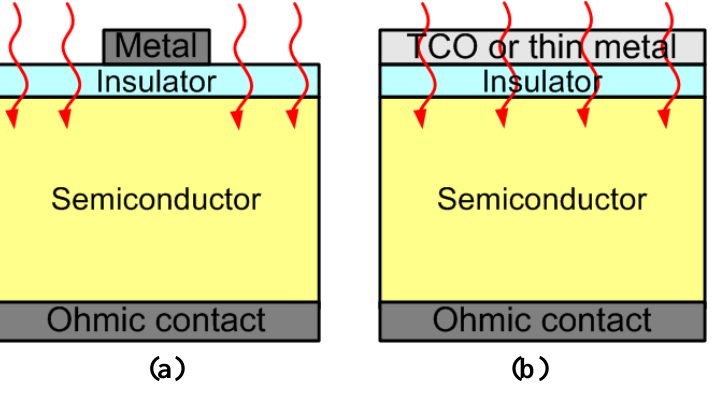
Figure 4. The schematic structures of metal-insulator-semiconductor photodetectors. (a) Light irradiates into the semiconductor from the unshadowed region when the metal is not transparent; (b) Light irradiates into the semiconductor passing through the transparent conducting oxide (TCO) or thin semi-transparent metal